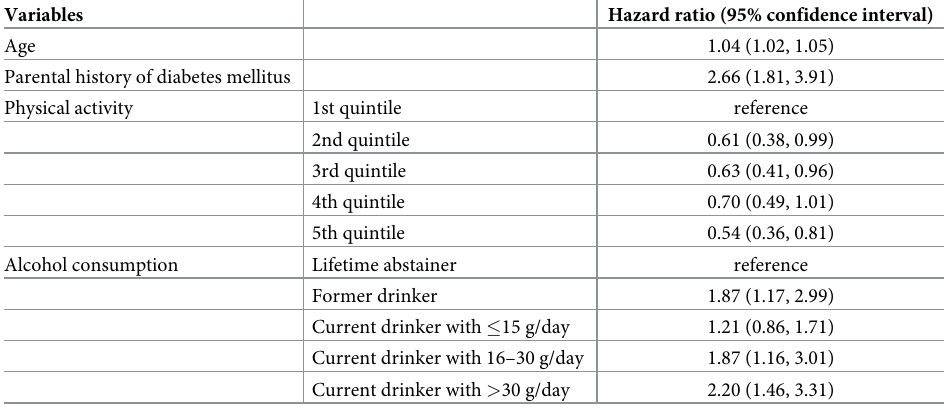
Table 4. Stepwise results on the association between alcohol consumption and 10-year incidence of type 2 diabetes mellitus in 2,014 participants who maintained leanness over the follow-up